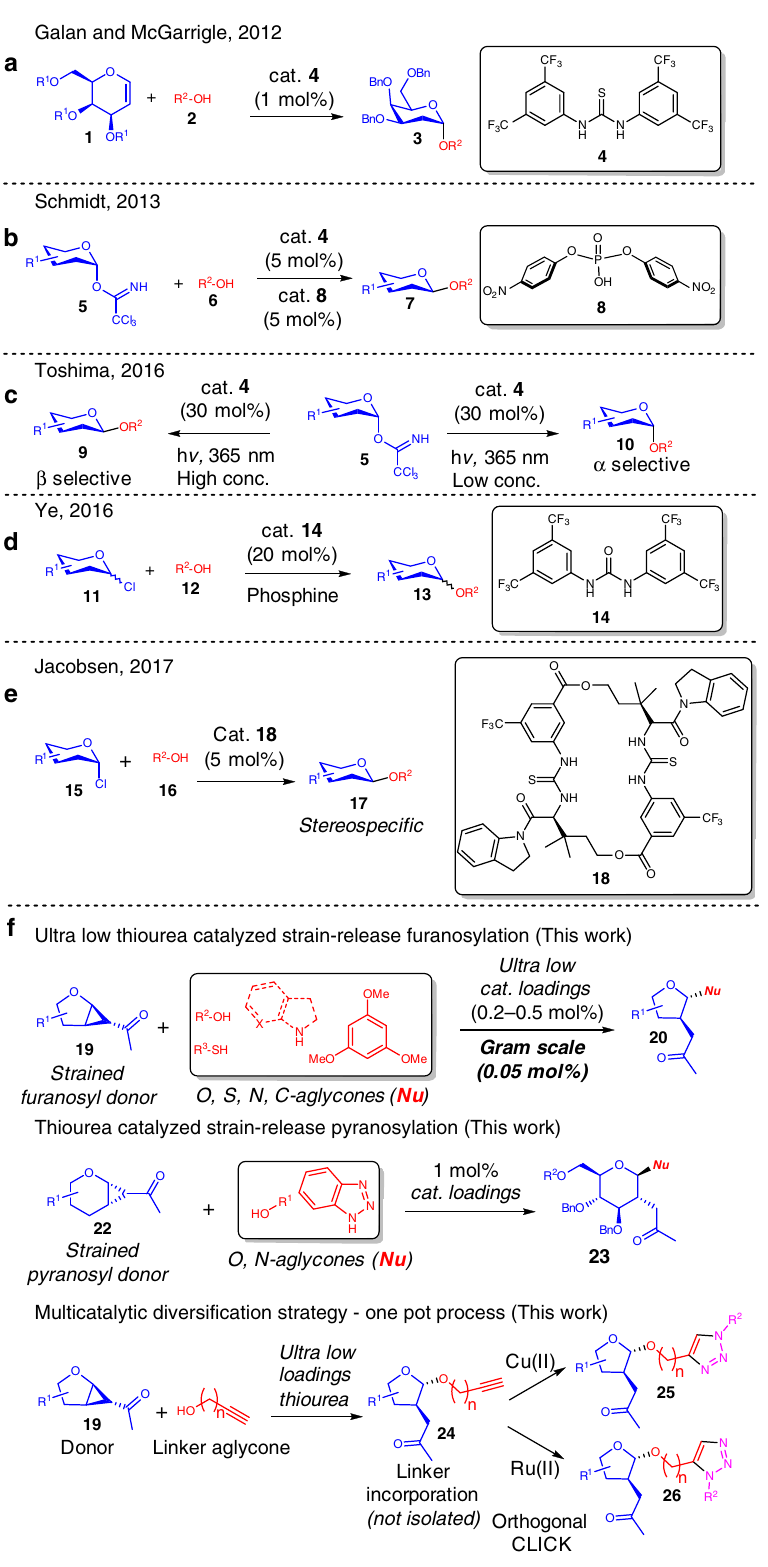
Fig. 1 Representative precedents in thiourea catalyzed pyranosylations. a Thiourea catalyzed access of 2-deoxyglycosides. b Co-catalysis of phosphoric acid and thiourea on trichloroacetimidate donors. c Concentration dependent thiourea catalyzed photoinduced catalysis. d Urea catalyzed Koenigs – Knorr glycosylation. e Macrocyclic thiourea catalyzed stereospeci fi c Koenigs – Knorr glycosylation. f Our reported methodology of an ultra-low thiourea catalyzed strain-release glycosylation and a one-pot multicatalytic diversi fi cation